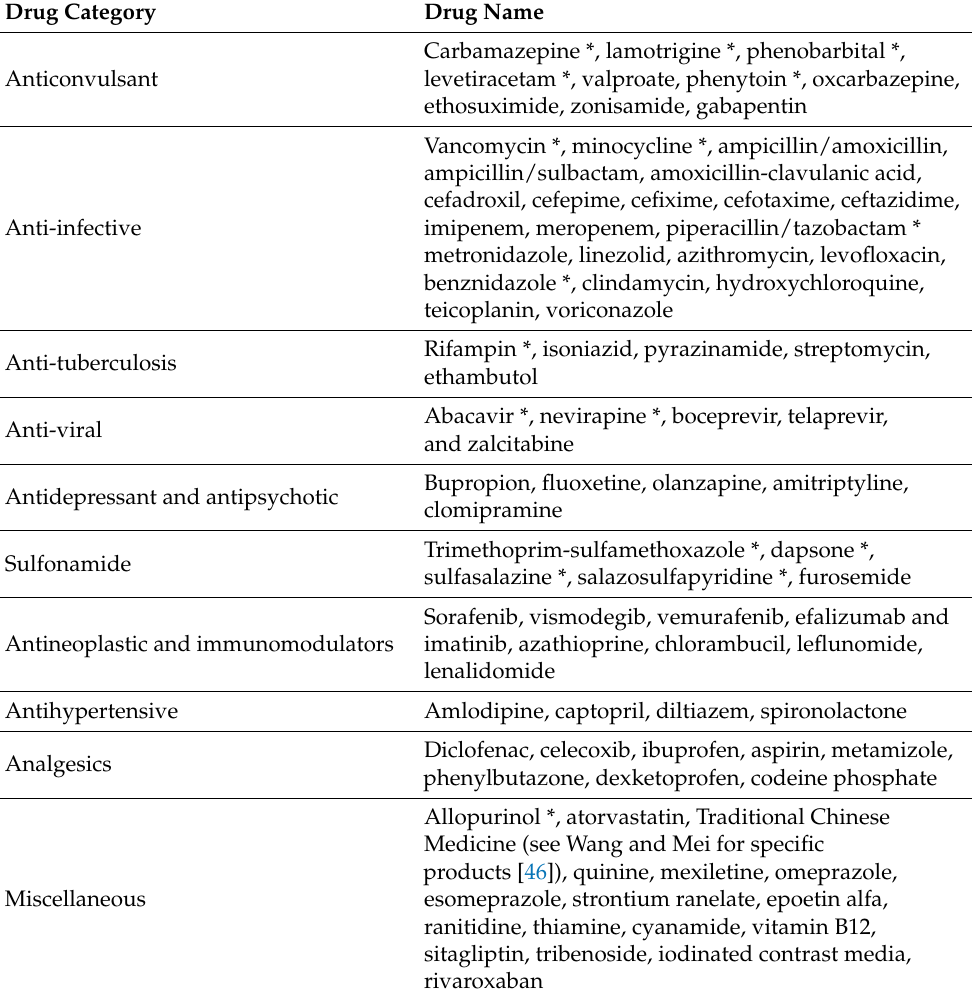
Table 1. Drugs associated with